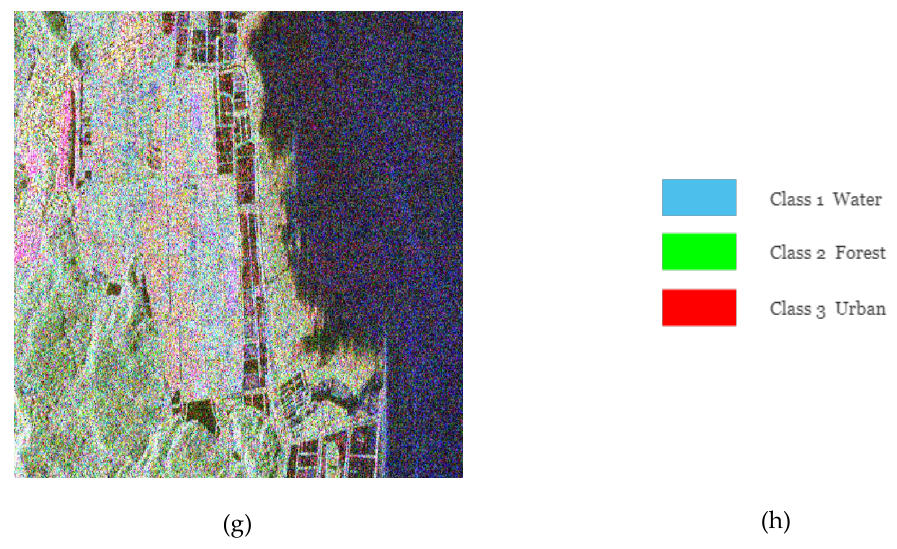
Figure 4. Polarimetric datasets used for the experiments. ( a ) Pauli color-coded image of the Flevoland data. ( b ) Ground truth map of Flevoland. ( c ) Class legend. ( d ) Pauli color-coded image of the Wallerfing data. ( e ) Ground truth map of Wallerfing. ( f ) Class legend. ( g ) Pauli color-coded image of the Fujian data.